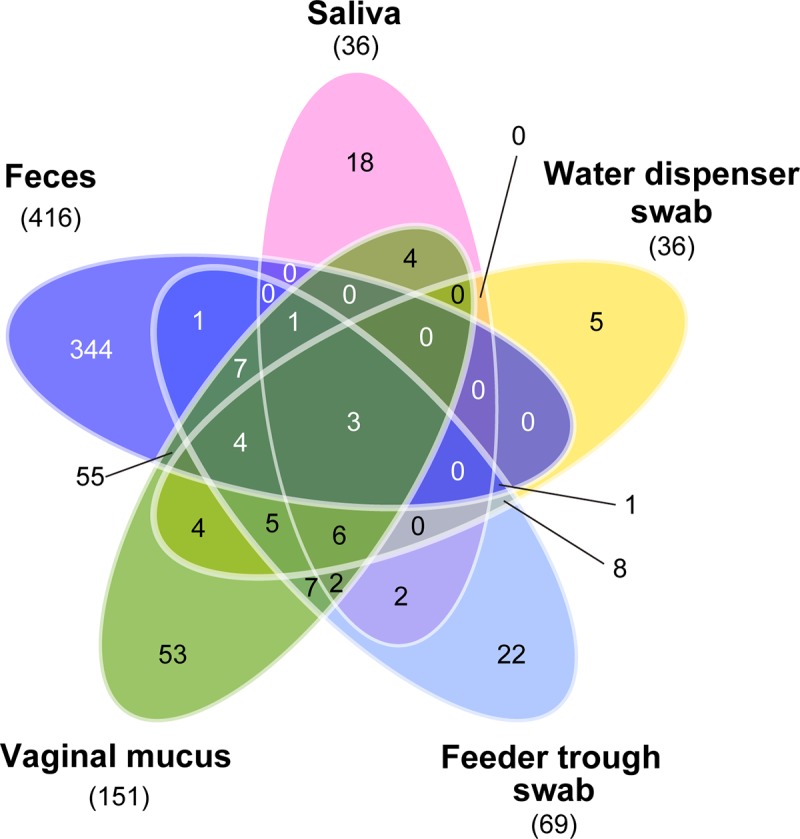
Comparison of OTUs between the five sample groups.The Venn diagram presents the common and unique OTUs among the five sample groups. The number of common OTUs is indicated in parenthesis under each sample name.